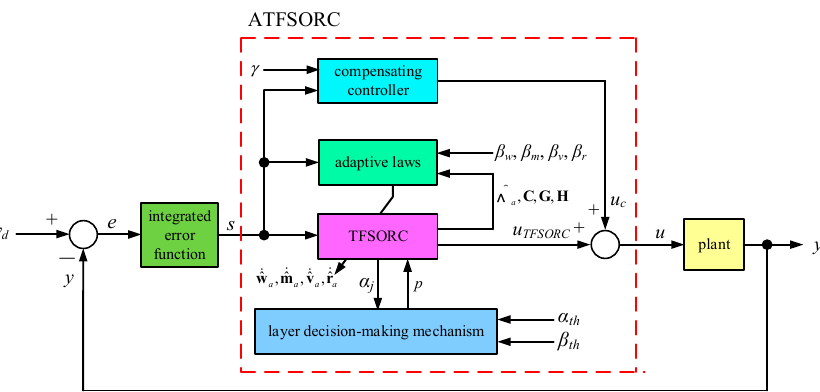
Figure 5. Adaptive TSK fuzzy self-organizing cerebellar model articulation controller architecture.